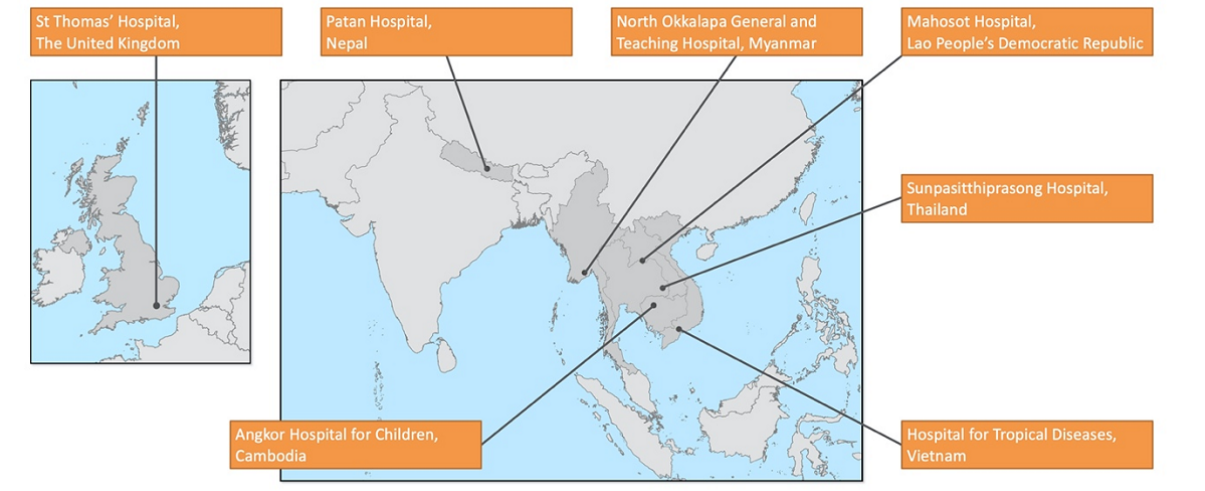
Figure 4. A map of participating hospitals and examples of summary data from the automatically generated antimicrobial resistance surveillance reports. The reports and summary data from St Thomas’ Hospital, Patan Hospital, North Okkalapa General and Teaching Hospital, Mahosot